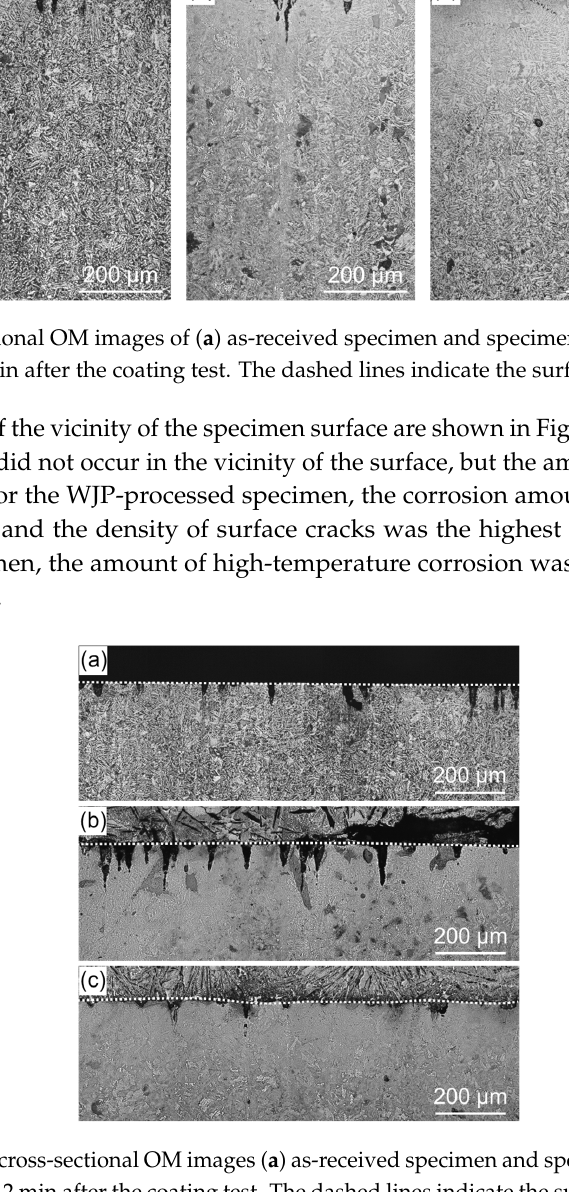
Figure 8. Relationship between corrosion weight loss and number of cycles in the coating test.